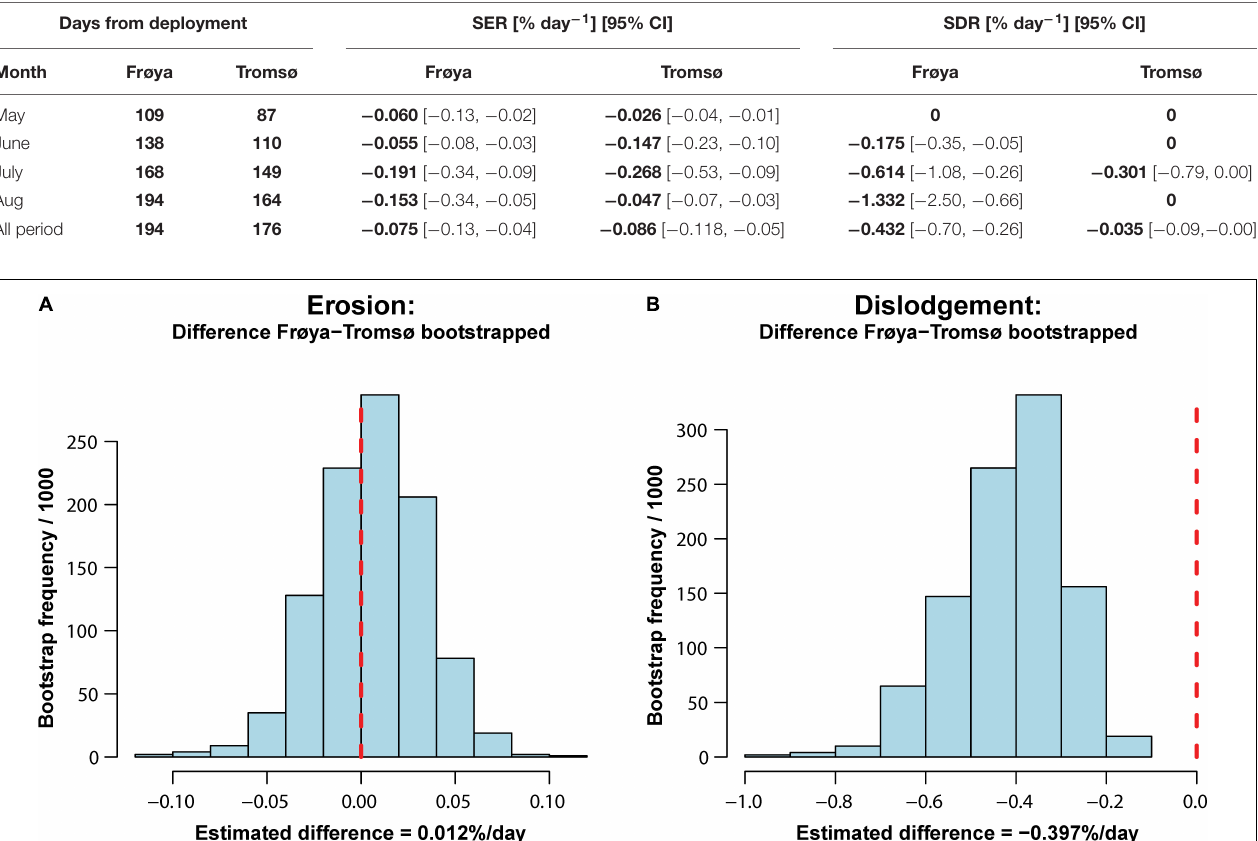
TABLE 2 | Comparison of specific rate of erosion (SER) and dislodgement (SDR) between Frøya and Tromsø February deployment (for selected months), and for the whole experimental period. Days from deployment